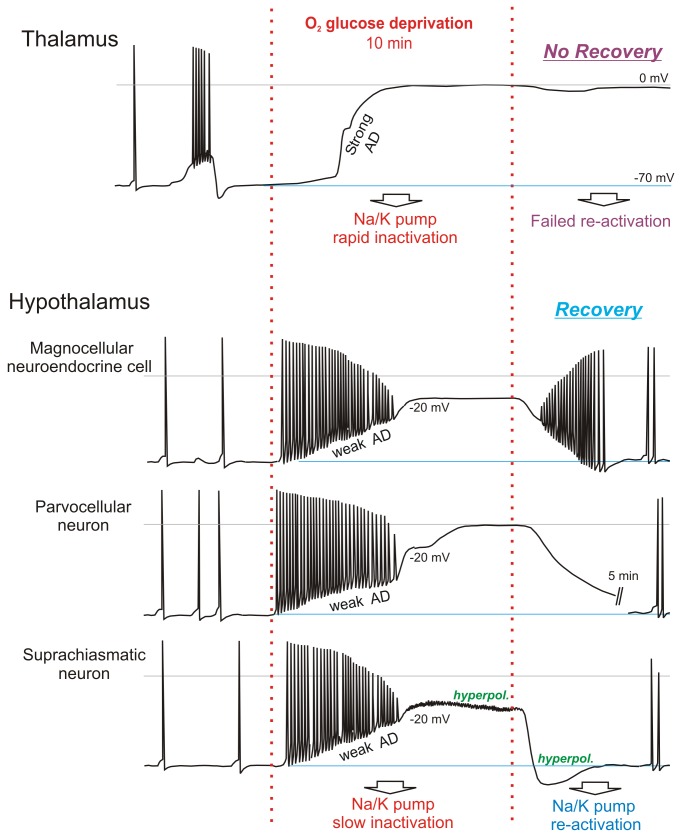
Summary of responses to OGD which varies with neuronal type.Like other neurons recorded in neocortex, striatum, hippocampus and cerebellar cortex, thalamic neurons undergo rapid AD to near-zero millivolts in response to OGD. They do not recover in brain slices exposed to 10 minutes OGD. In contrast, three types of hypothalamic neuron undergo gradual and often incomplete AD that usually plateaus at ~ 20 mV. Moreover these neurons substantially repolarize post-OGD. Some SCN neurons can even hyperpolarize in the face of OGD and this elevated pumping is reflected as a post-OGD hyperpolarization. We propose that hypothalamic neurons possess more resilient versions of the Na+/K+ pump than thalamic neurons.